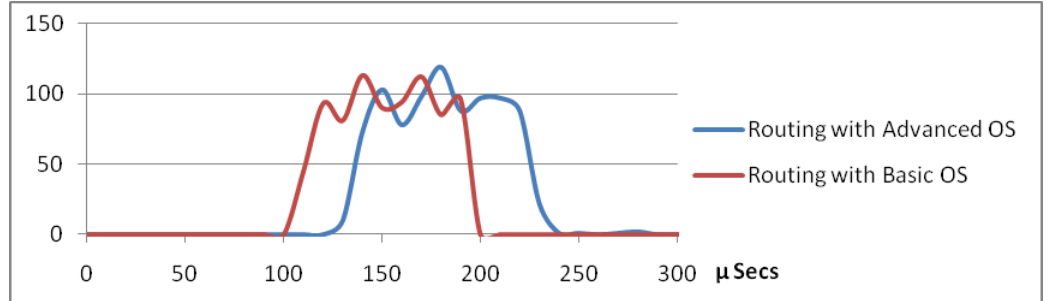
Figure 2. Delay through router with different